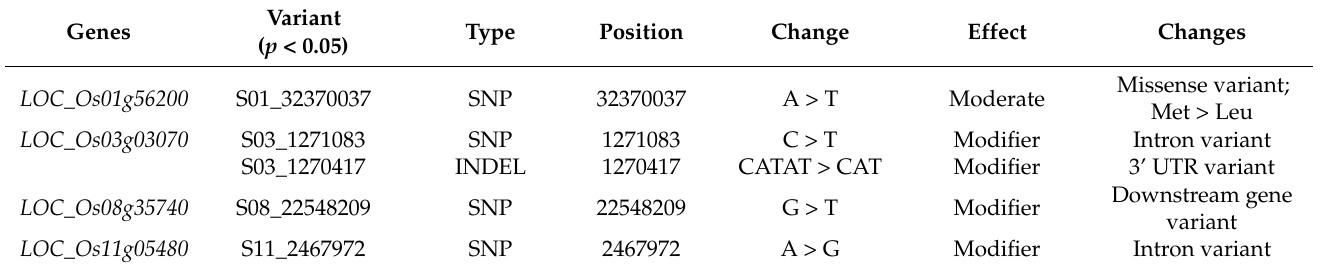
Table 8. Significant variants predicted to have impact on the